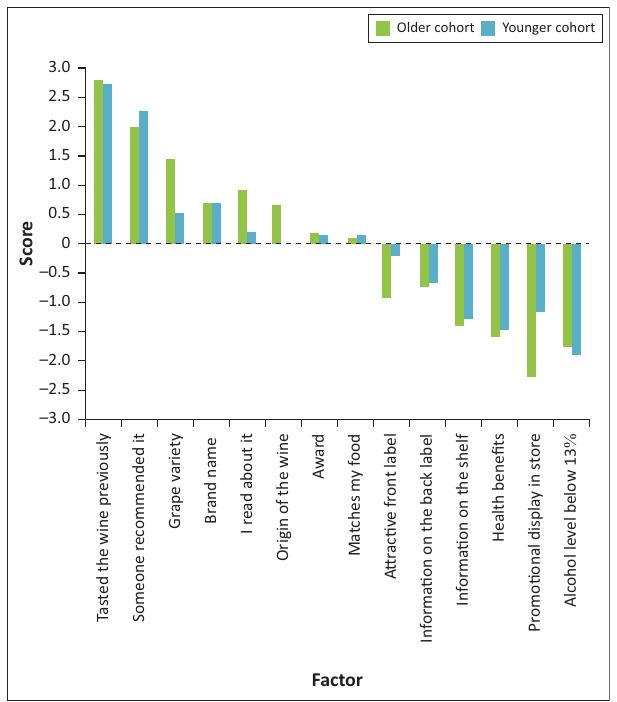
FIGURE 1: Best–worst scaling scores for the two age